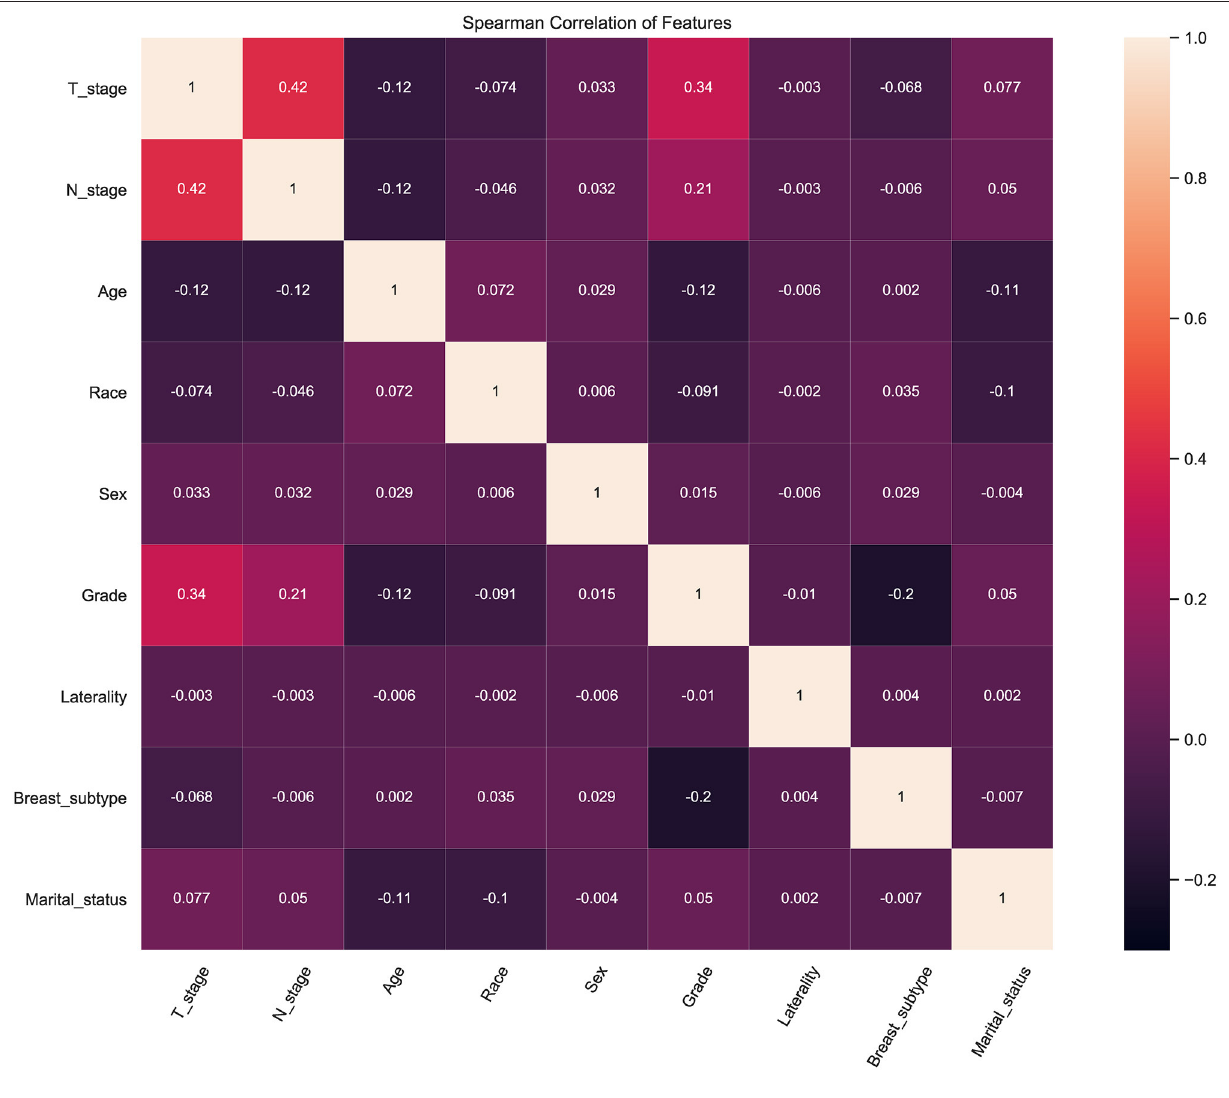
FIGURE 2 | Results of correlation analysis between all